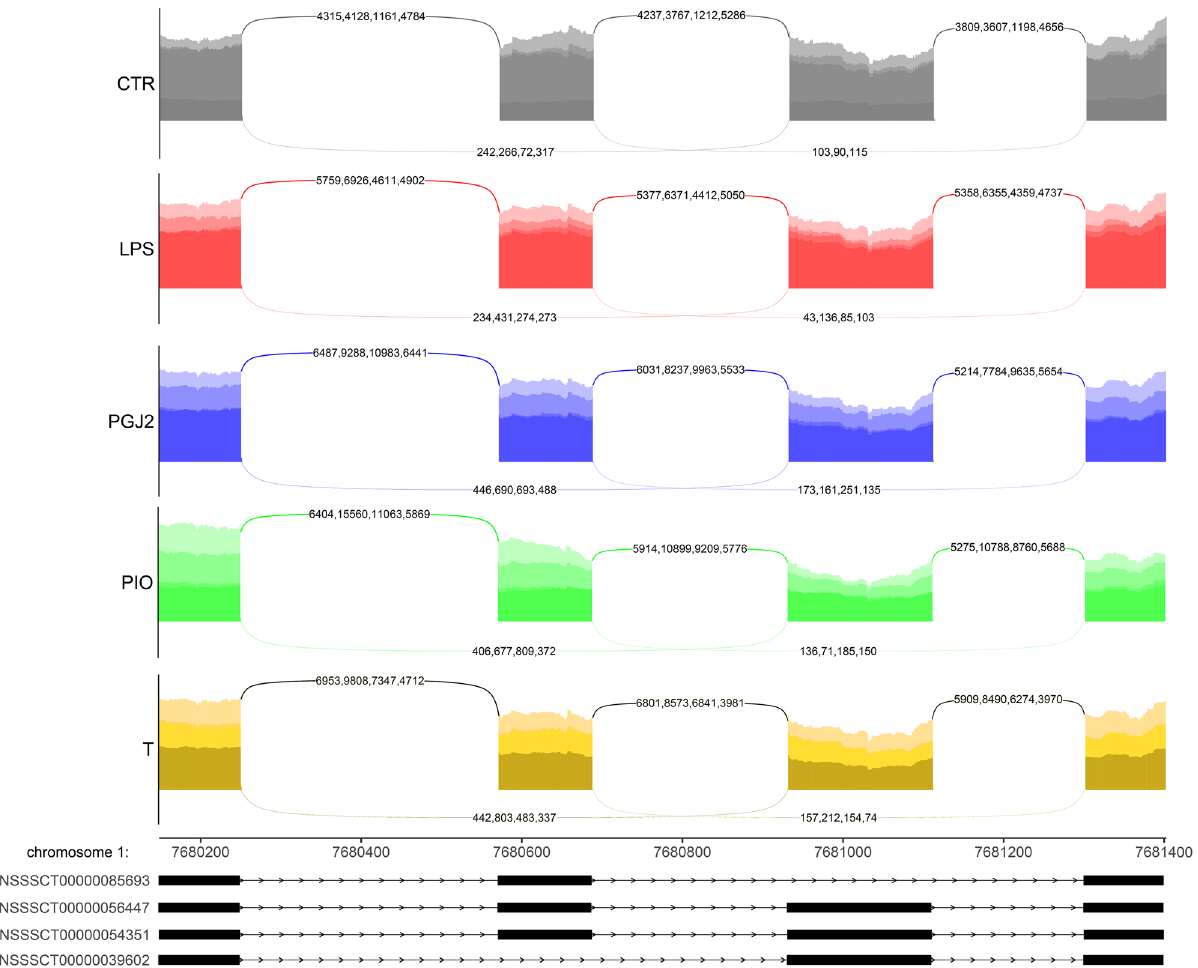
Figure 5. Sashimi plot (quantitative visualization) of differential alternative splicing events (DASEs) in the SOD2 gene. Upper colored tracks represent the experimental conditions within mutually exclusive exons (MXEs). The numbers on curved lines indicate the number of counts for each splice junction. The middle track depicts the genomic coordinates of DASEs on the chromosome. The bottom tracks represent exons engaged in DASEs. The plot was generated in ggsashimi Python